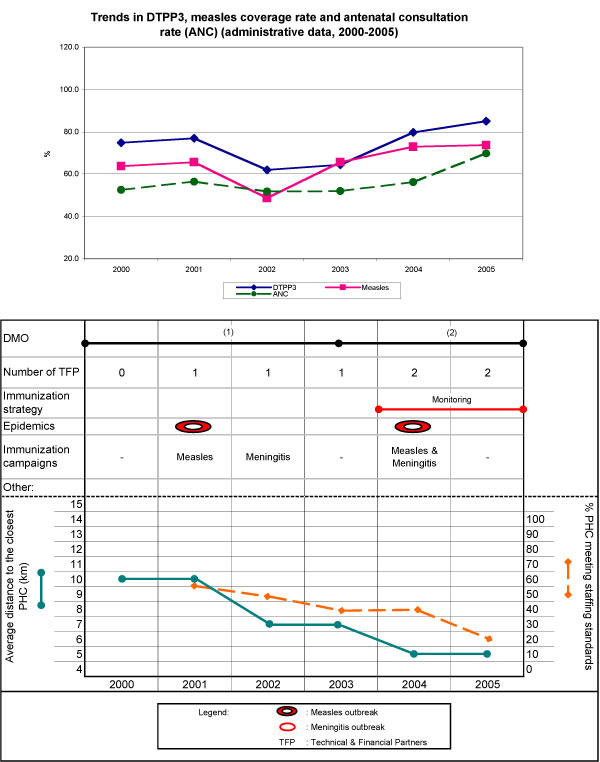
Health district of Mandé.